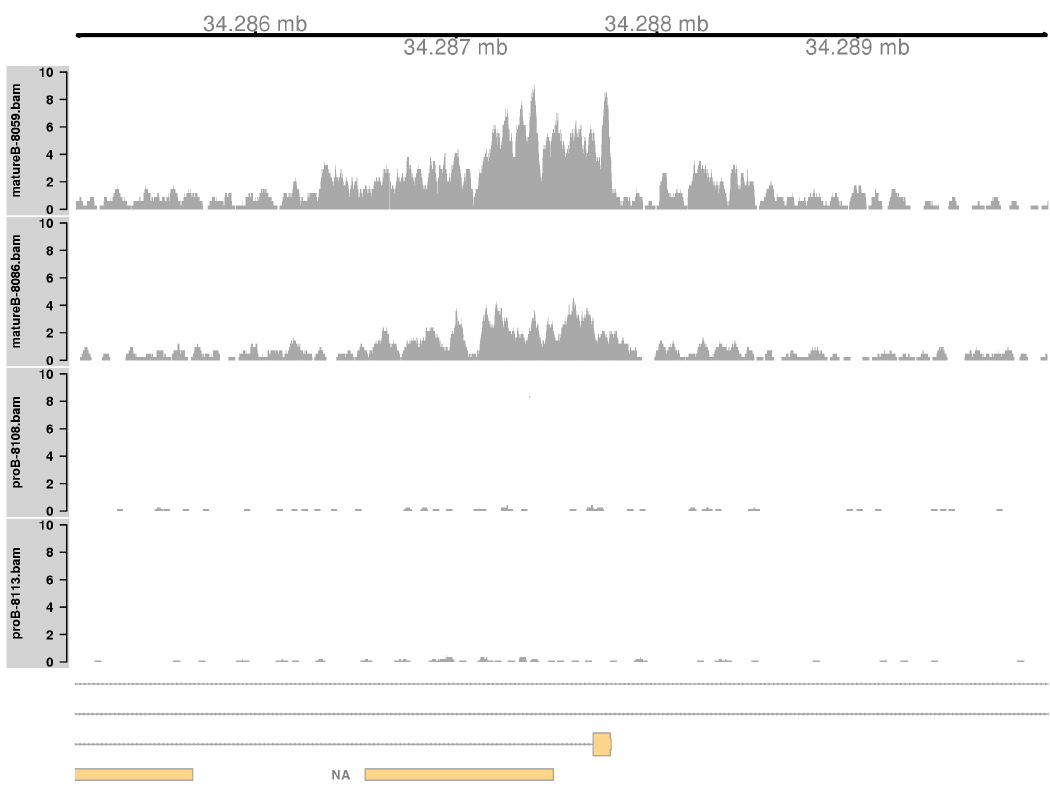
Figure 8. Coverage tracks for a simple DB event between pro-B and mature B cells, across a broad region in the H3K9ac data set. Read coverage for each library is shown as a per-million value at each